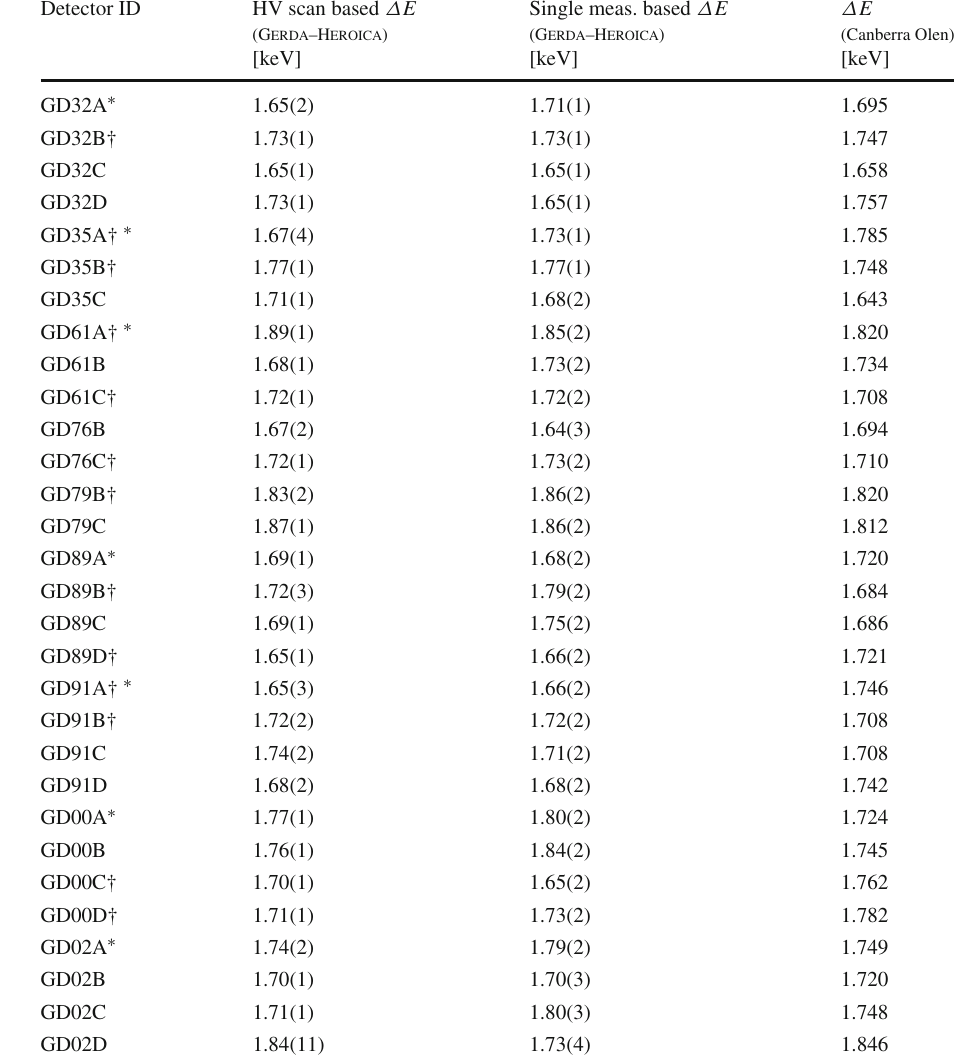
Detector ID HV scan based Δ